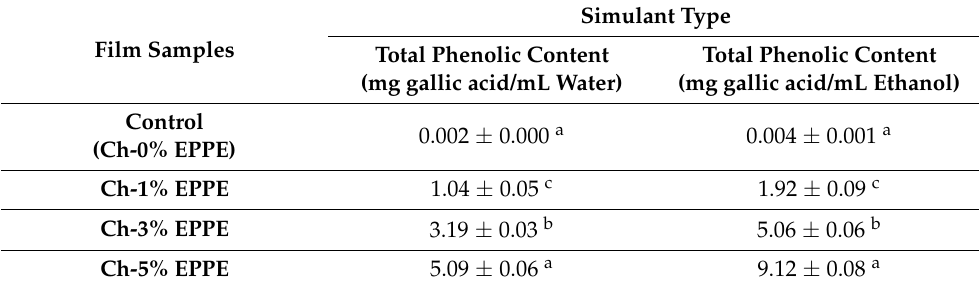
Table 4. Migration test of chitosan films modified with 0 to 5% EPPE.